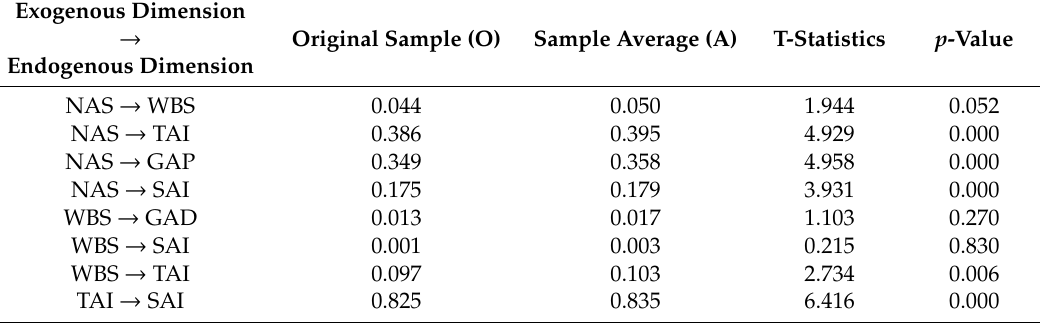
Table 12. Size of the f 2 e ff ect for the PANAS-GAD-7-IDATE model.